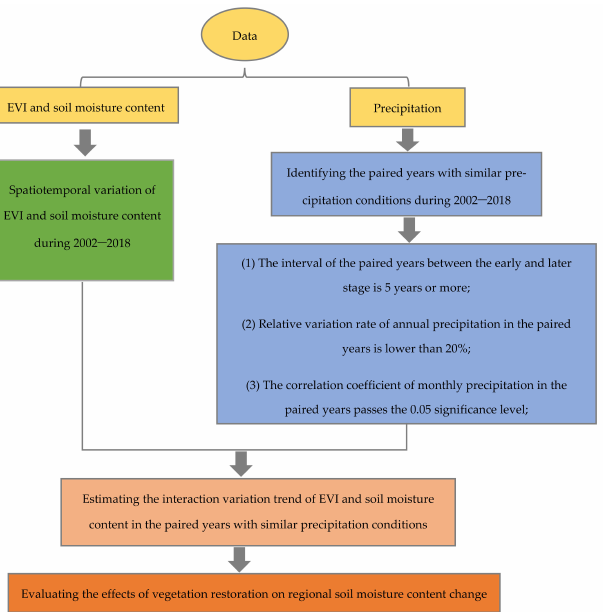
Figure 2. The flow chart of evaluating the effects of vegetation restoration on regional soil moisture content in the humid karst